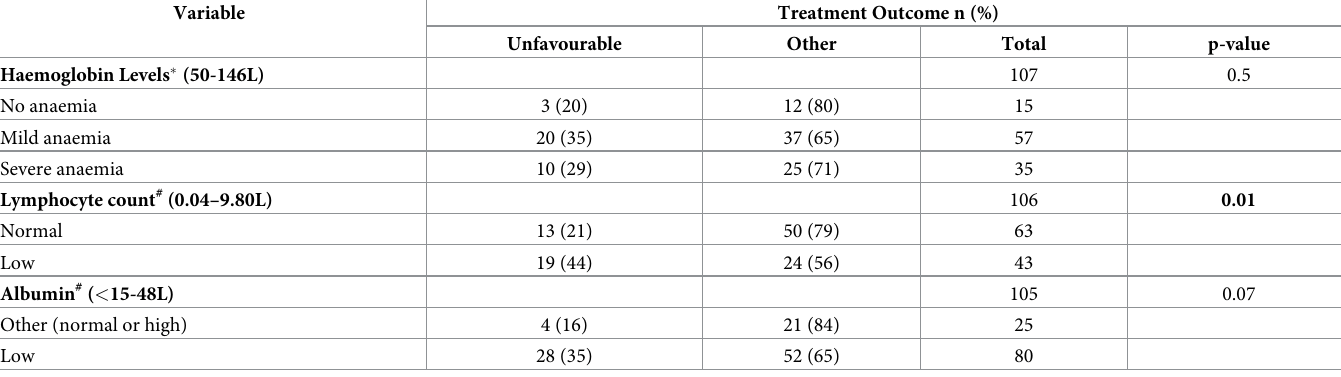
Table 3. Blood test abnormalities in patients diagnosed with drug-resistant tuberculosis in the Torres Strait between 2000 and 2020, and their association with treatment outcome.